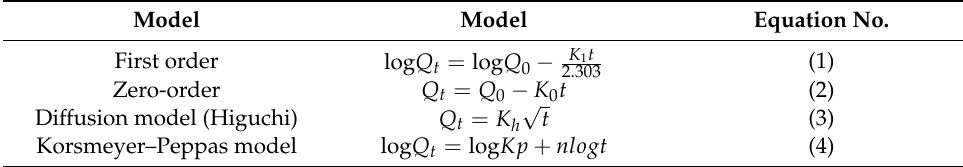
Table 7. Kinetic models equations